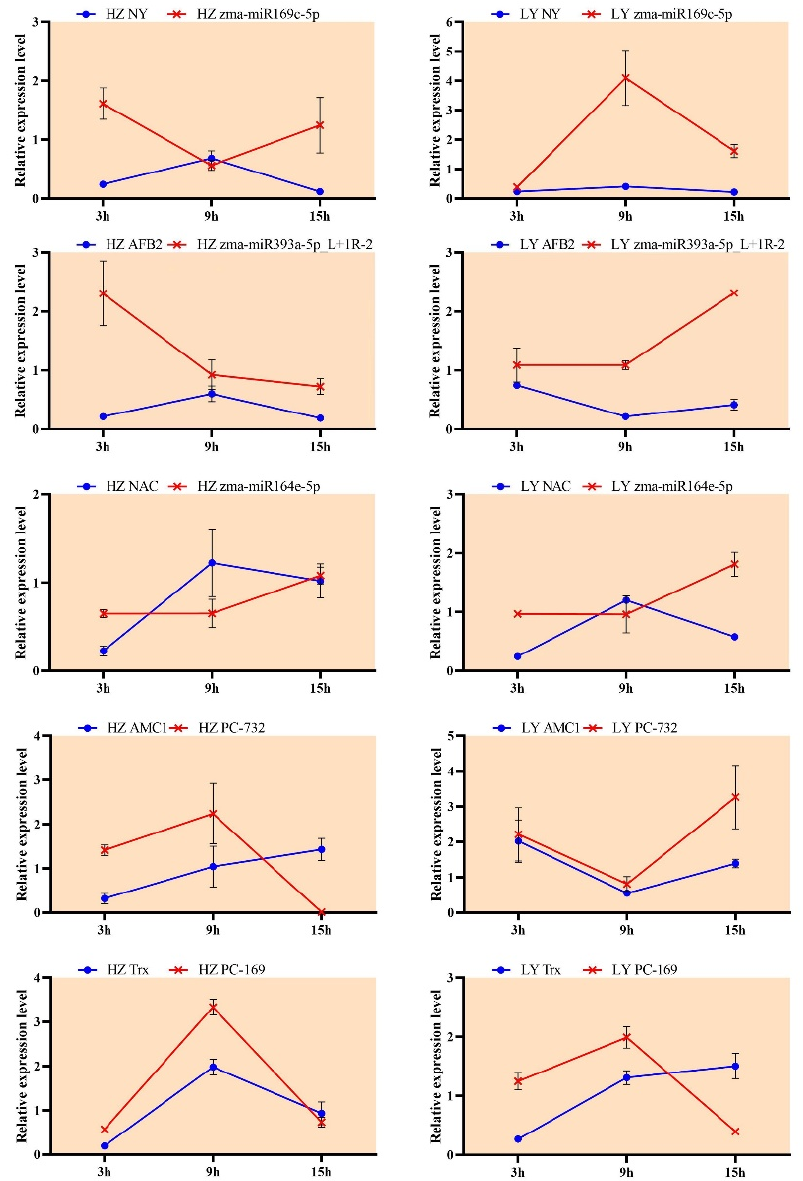
Figure 6. The expression pattern of 5 miRNAs and their targets in HZ ( left ) and LY ( right ) infected by C. lunata . zma-miR169, zma-miR393, zma-miR164, PC-732 and PC-169 were abbreviated names of miRNAs, and their full names were zma-miR169c-5p, zma-miR393a-5p_L+1R-2, zma-miR164e-5p, PC-3p-73272_34 and PC-3p-169098_11, respectively.